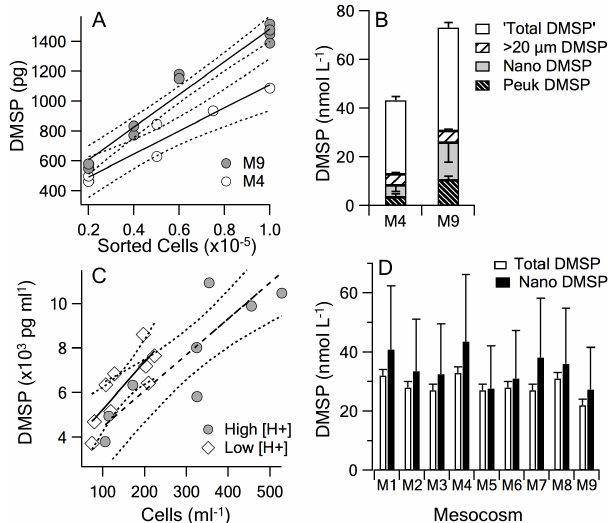
Fig. 7. Contributors to DMSP production: (A) differences in the DMSP content of picoeukaryote phytoplankton sorted by flow cytometry collected from mesocosm 4 and meso- cosm 9 on t21. Coefficients ( ± SD) of the linear regres- sion are: M4, y = 340 ( ± 190) + 0.008( ± 0.003) x ; M9, y = 390 ( ± 130) + 0.011( ± 0.002) x . (B) Components of DMSP during PII on t18 in mesocosm 4 and mesocosm 9 when picoeukaryote abun- dance was highest; Peuk: picoeukaryote; Nano: nanoeukaryote; > 20µm: component retained by a 20µm filter. The Peuk compo- nent was based on abundance and cell-specific DMSP-content mea- sured on t21; the Nano component was based on abundance and the range of values obtained in North Atlantic waters (Archer et al., 2011). (C) Abundance of Heterocapsa rotundata versus DMSPt concentration in mesocosms 5 and 9 during PII. The fitted re- gressions are: M9, y = 2 . 85 ( ± 1.11) + 0.016 ( ± 0.003) x ; and M5, y = 3 . 12 ( ± 0.90) + 0.021 ( ± 0.005) x . (D) Estimated contribution of nanoeukaryotes (Nano) to DMSP during PI. Values for total DMSP are the mean and range during PI, values for Nano DMSP are based on the mean and range of cell-specific values (0.96 (0.5–1.6) pg DMSP cell − 1 ) measured in North Atlantic waters (Archer et al., 2011). The dotted lines mark the 95% confidence intervals for each linear